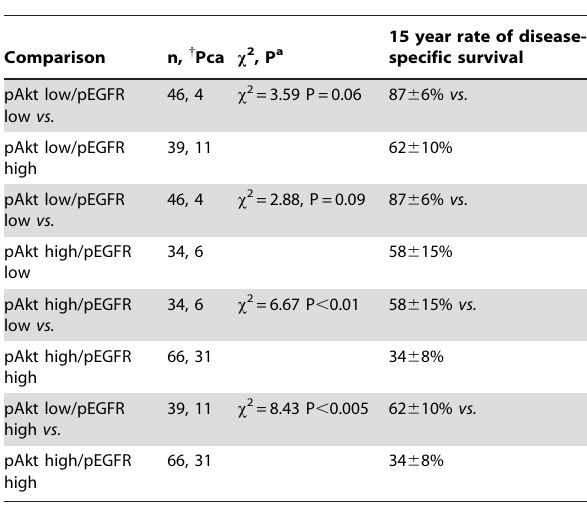
‘‘low’’ and ‘‘high’’ refer to the cut-offs shown in Fig. 3B. { Pca refers to the number of patients who died as a result of their prostate cancer during the follow-up period. a Log-rank (Mantel-Cox)